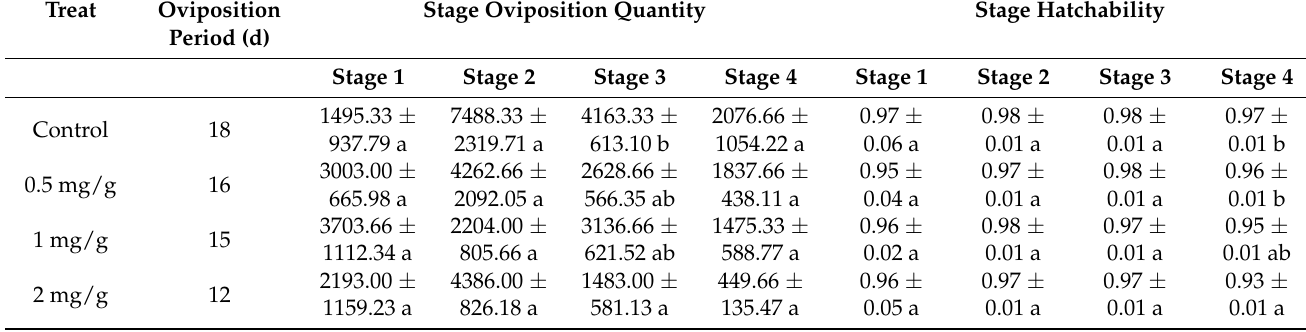
Table 7. Total oviposition period and fecundity of Spodoptera frugiperda fed with different GO